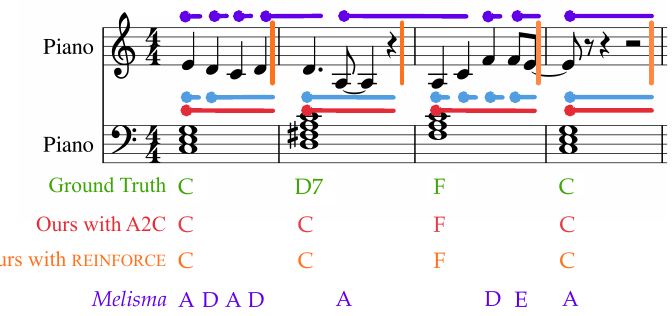
Figure 12. A sample from “Eight Days A Week” by the Beatles processed by our model and Melisma in C major